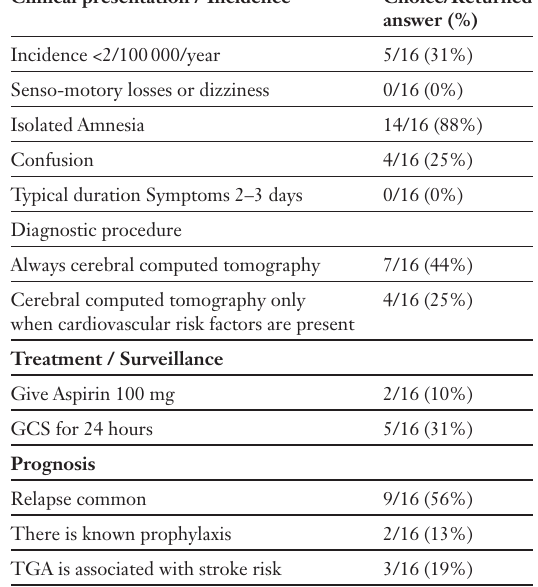
Questionnaire about diagnosis, treatment and prognosis of